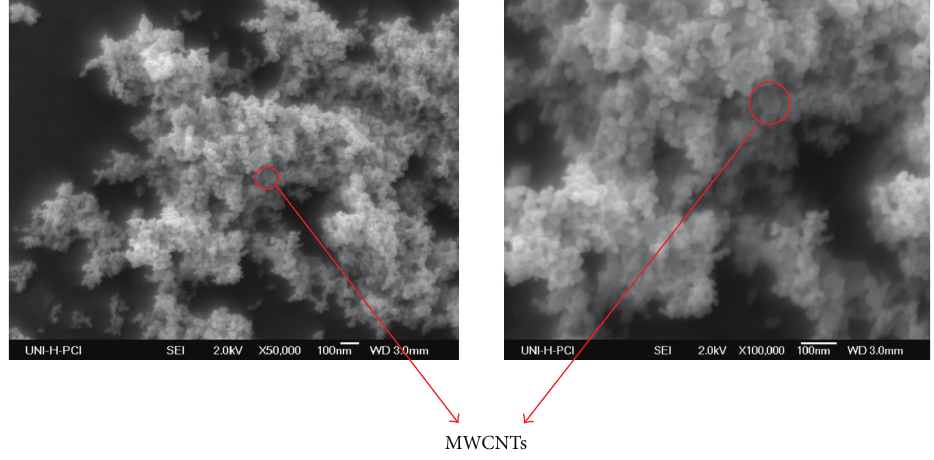
Figure 8: SEM images of the MWCNTs (0.5%)/P25